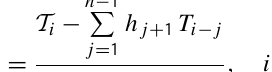
www.earth-syst-sci-data.net Earth Syst. Sci. Data